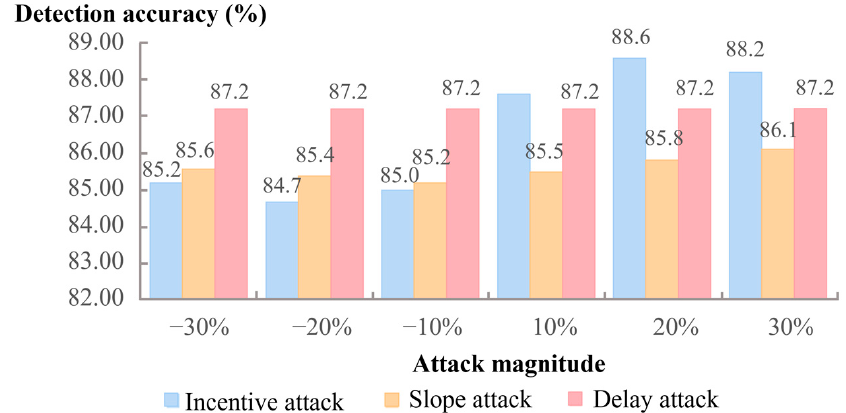
Figure 22. Detection accuracy for different attack modes.